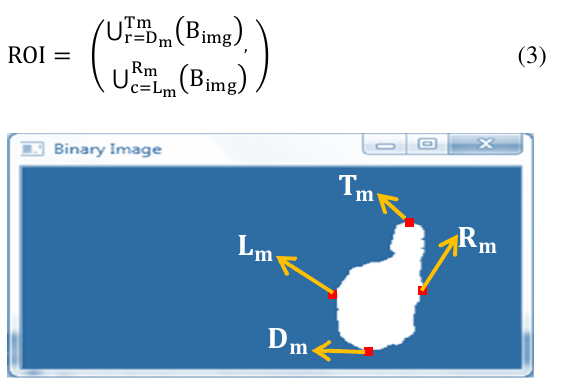
Fig. 4: (a) The FR img , (b) The ROI Image and (c) The Thumb Template (TT).